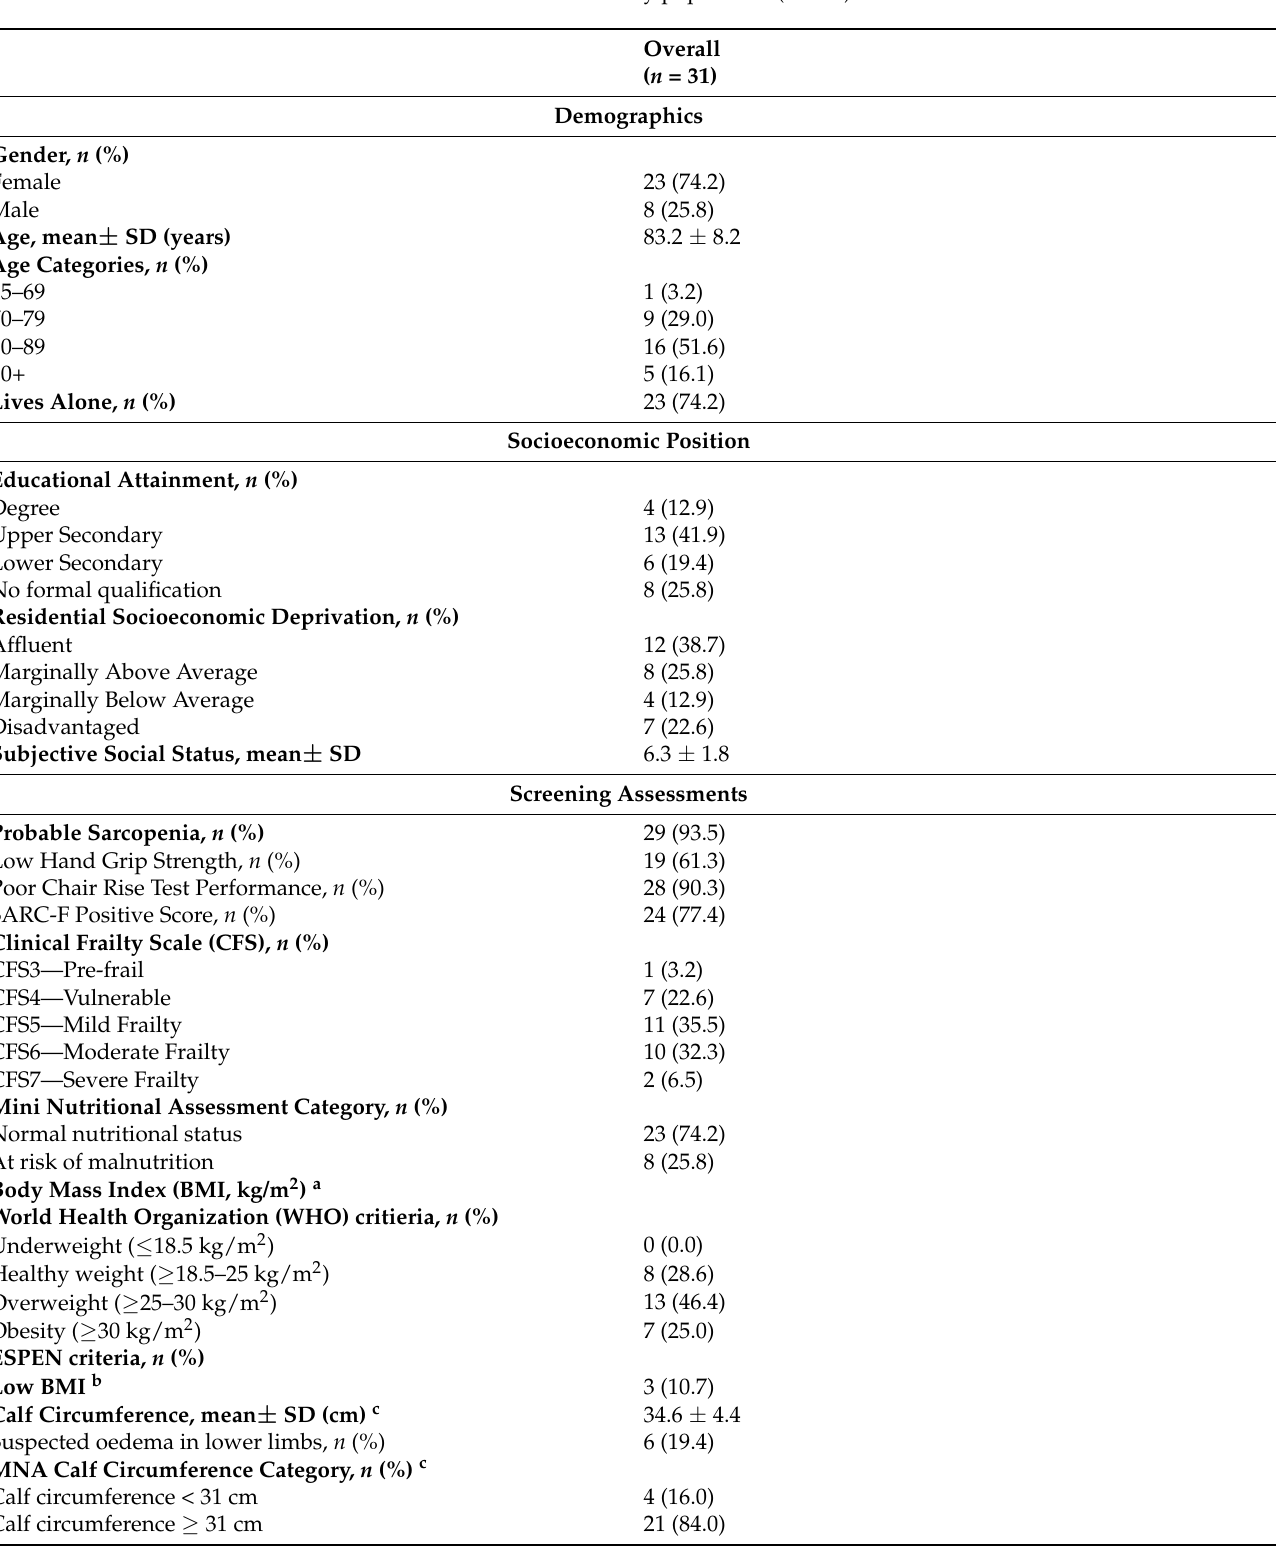
Table 1. Characteristics of the study population ( n =